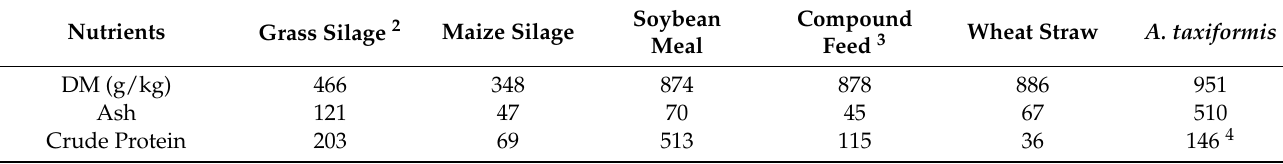
Table 2. Chemical composition (g/kg DM, unless stated otherwise) of the different ingredients in the basal diet and of the seaweed A. taxiformis fed to dairy cows. Diet consisted of grass silage, maize silage, soybean meal, compound feed, and wheat straw, with a ratio of 57:25:12:3:2 1